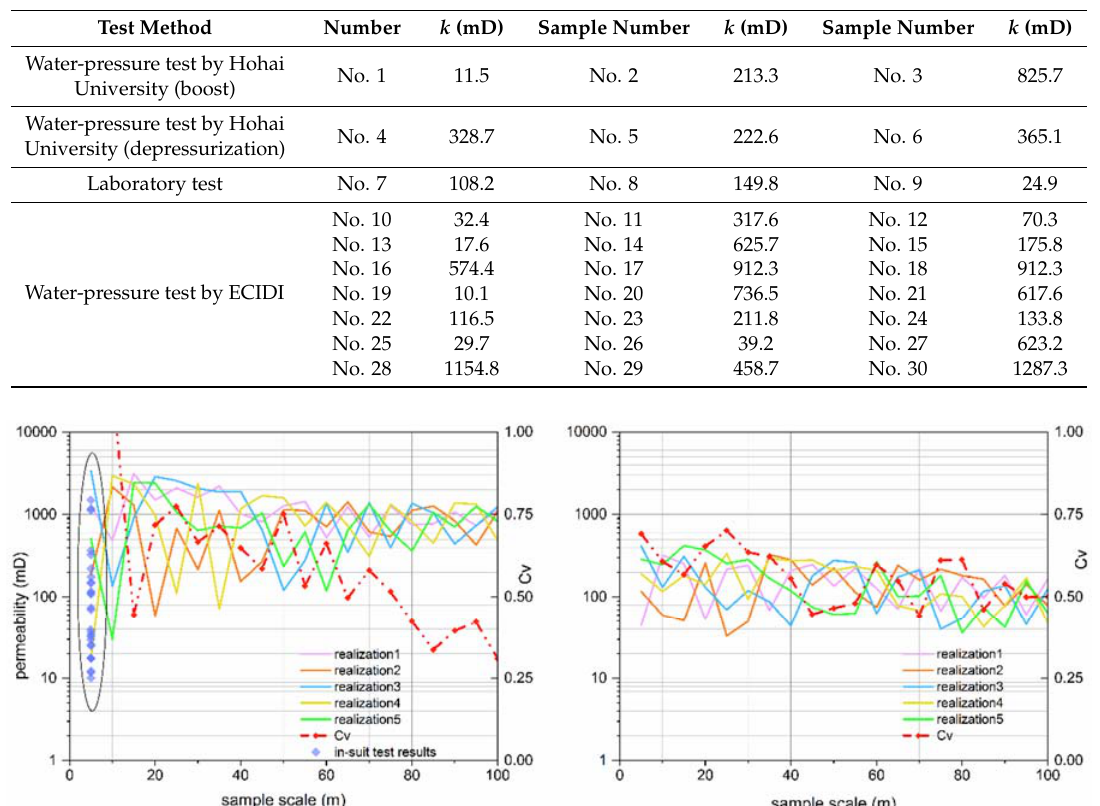
Table 7. Field-test results of permeability for C 3 .